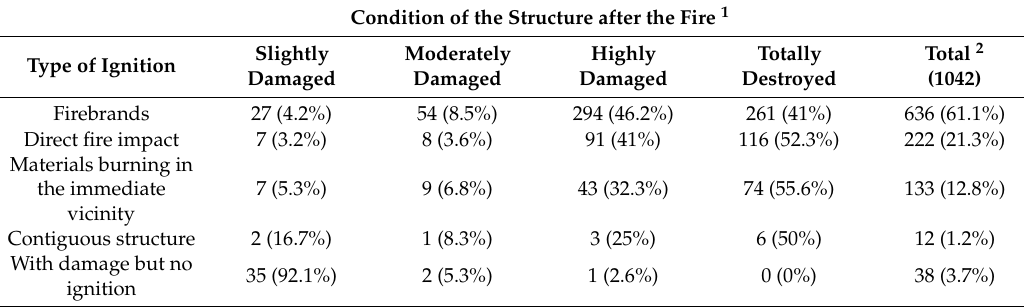
Table 10. Degree of damage according to the type of ignition.